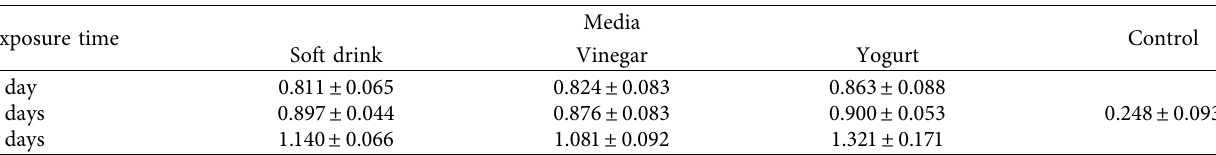
Table 6: Carbonate to phosphate (mean ± SD) in the dentin of tooth samples after exposure to different media at variable times, including the control